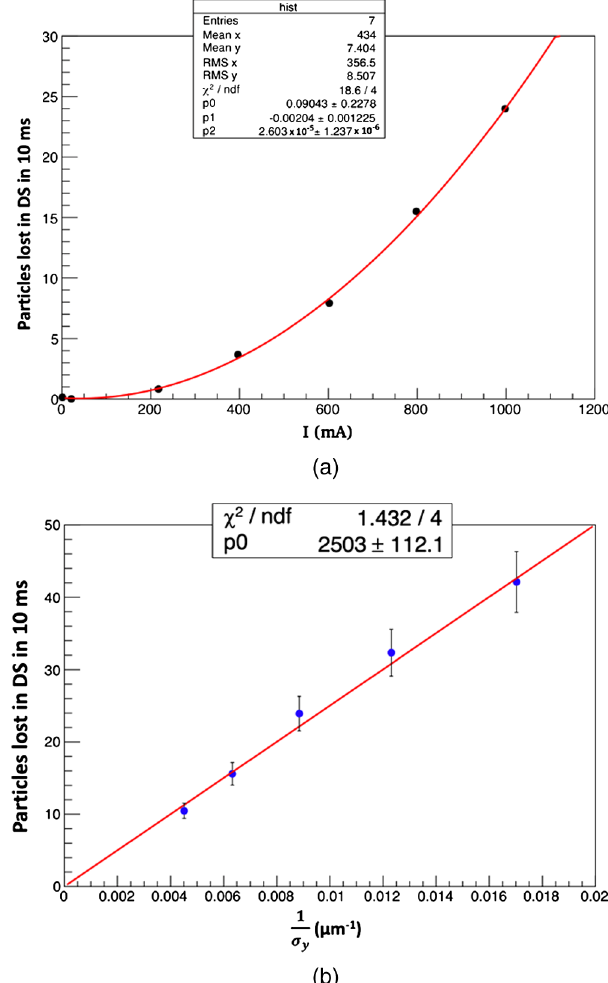
FIG. 6. (a) Simulation of expected Touschek loss rate in the DS in 10 ms as a function of the beam current and (b) as a function of the inverse vertical beam size.